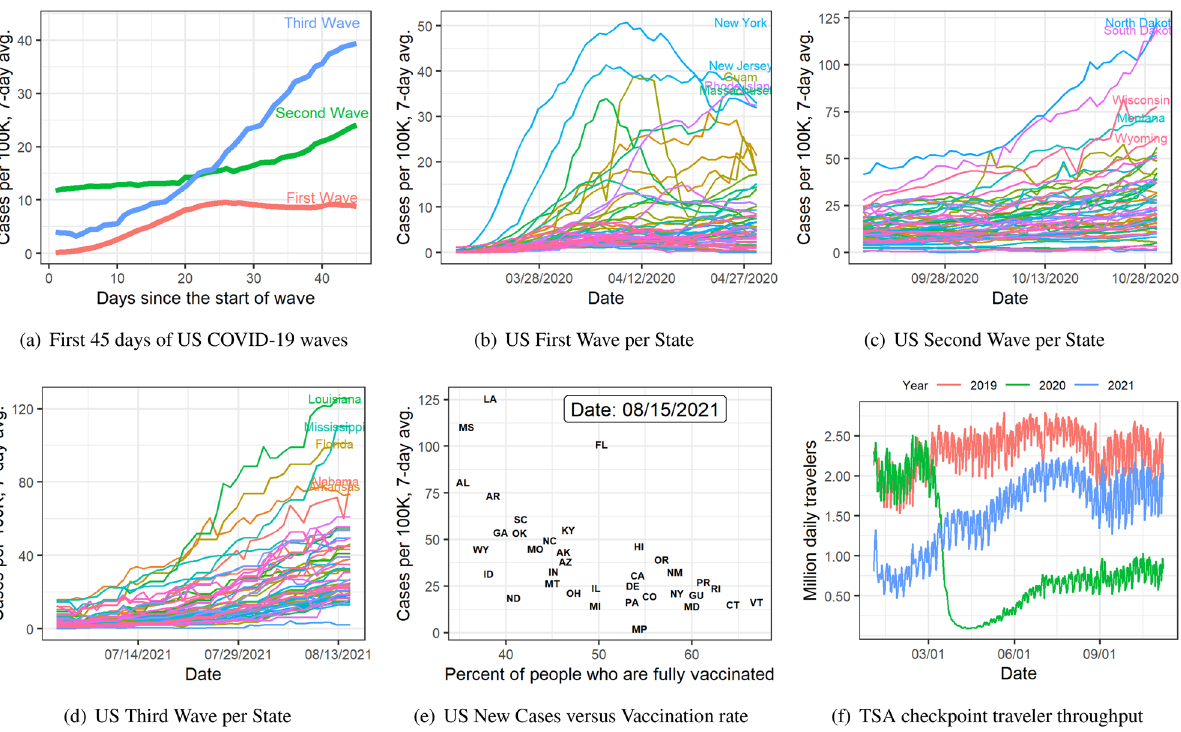
Figure 6. Plot ( a ) shows the seven days rolling average new cases per 100 thousand people during the first 45 days of the US first wave (03/15/2020–4/19/2020), the US second wave (09/15/2020–10/30/2020), and the US third wave (07/01/2021–2021/08/15). Plots ( b ), ( c ), and ( d ) show the seven days rolling average new cases per hundred thousand people during the first 45 days of the first, second, and third waves respectively by state. ( e ) New cases per 100,000 people versus percent of people who are fully vaccinated (have second dose of a two- dose vaccine or one dose of a single-dose vaccine) based on the state where recipient lives on 4th day of the third wave (08/15/2021). Plot ( f ) displays the Transportation Security Administration (TSA) checkpoint travel numbers for years 2019, 2020, and 2021 on the same weekday. Source cases data 17 , vaccines data 18 , TSA traveler throughput data 19